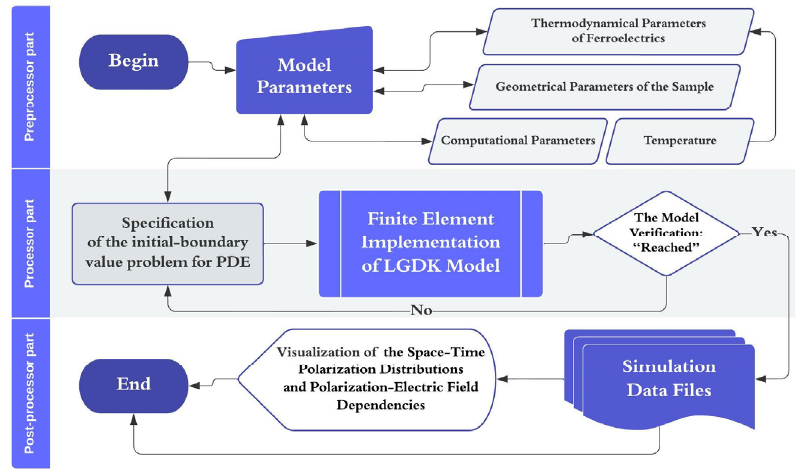
Figure 1. Functional block diagram of the model implementation.